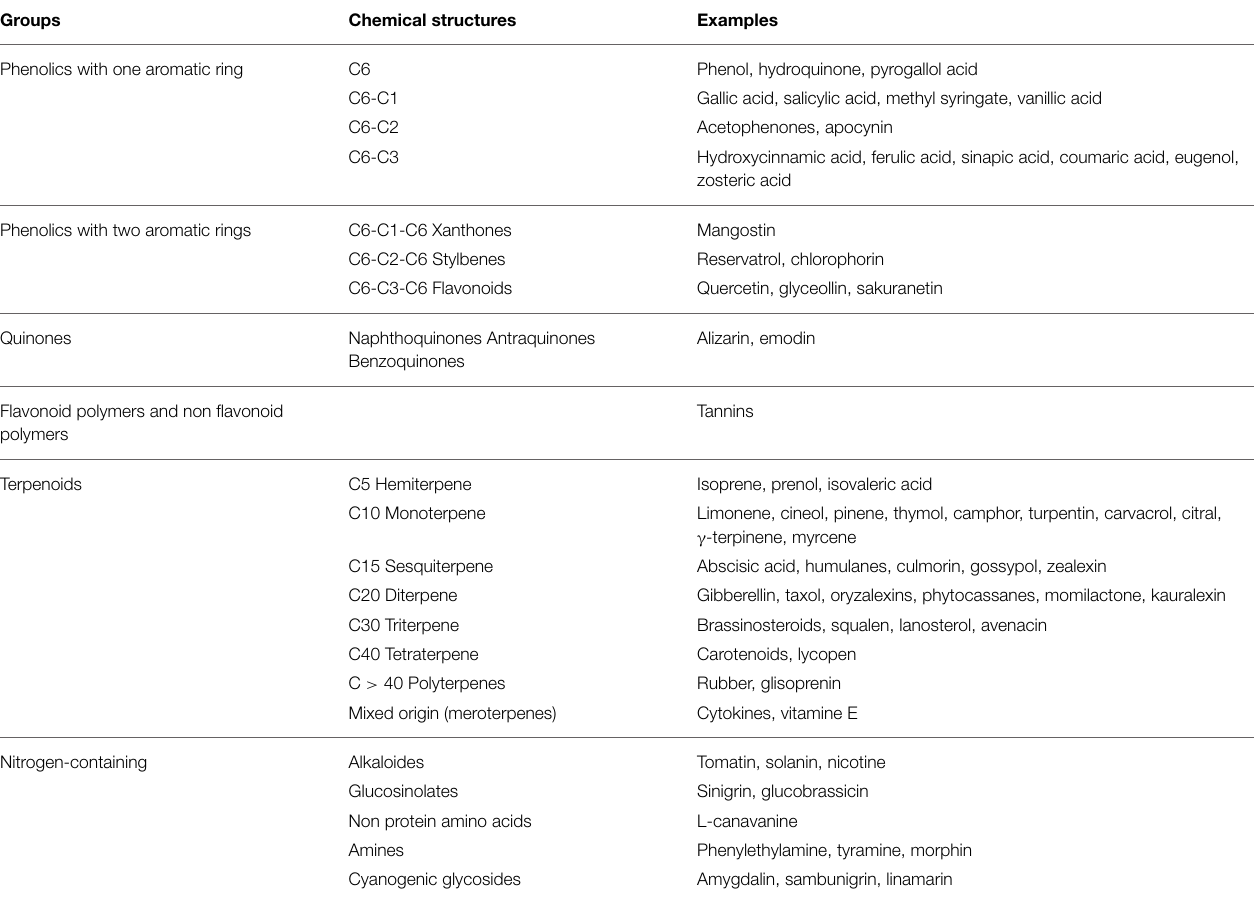
TABLE 2 | Classification of plant secondary